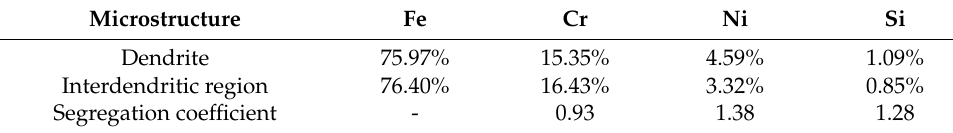
Table 2. Elemental contents of the powder and their segregation coefficients.